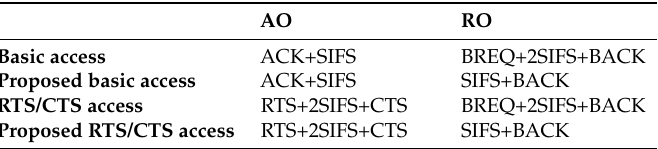
Table 2. Decomposition of channel utilization